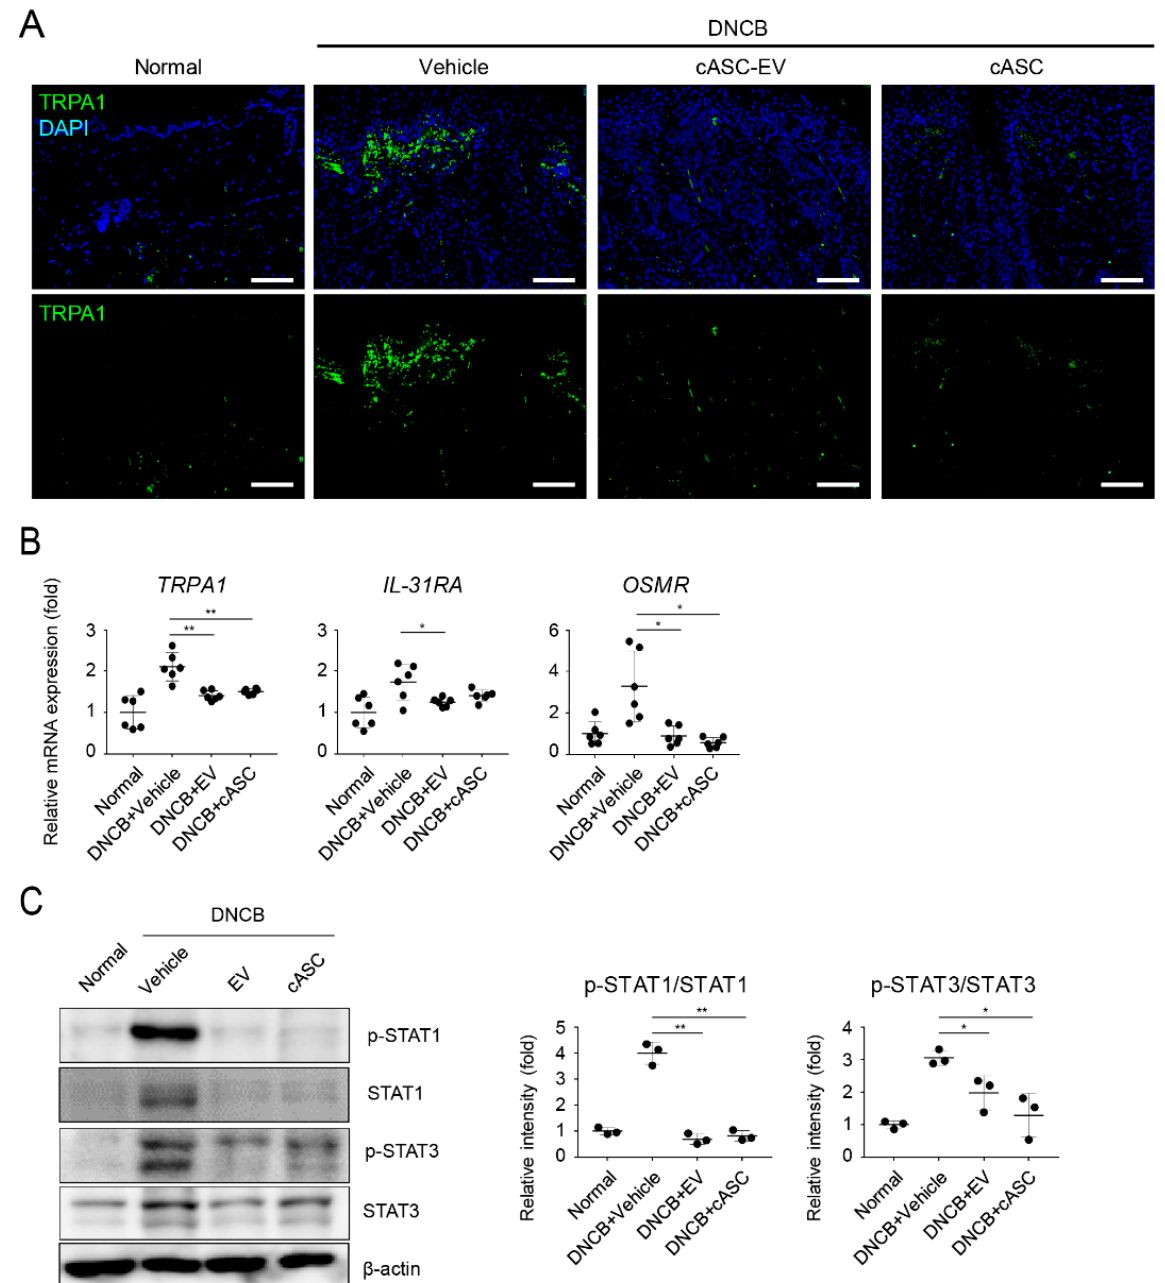
Figure 5. cASC and cASC-EV inhibit pruritogen responses through downregulation of phosphoryla- tion of STATs in atopic dermatitis-like skin lesion of Balb/c mice. ( A ) Tissue sections from back skins stained with TRPA1 using Immunofluorescence. Scal bar = 100 µ m. ( B ) The expression of TRPA1, OSMR and IL-31RA genes in skin tissues; each group represented using real-time PCR ( n = 6/group). ( C ) Immunoblots with anti-p-STAT1, anti-STAT1, anti-p-STAT3, anti-STAT3 or anti- β -actin antibodies using lysates from skin. Western blots were analyzed quantitatively. All data represent mean ± SD. Significant value was * p < 0.05, ** p < 0.01 vs. DNCB +